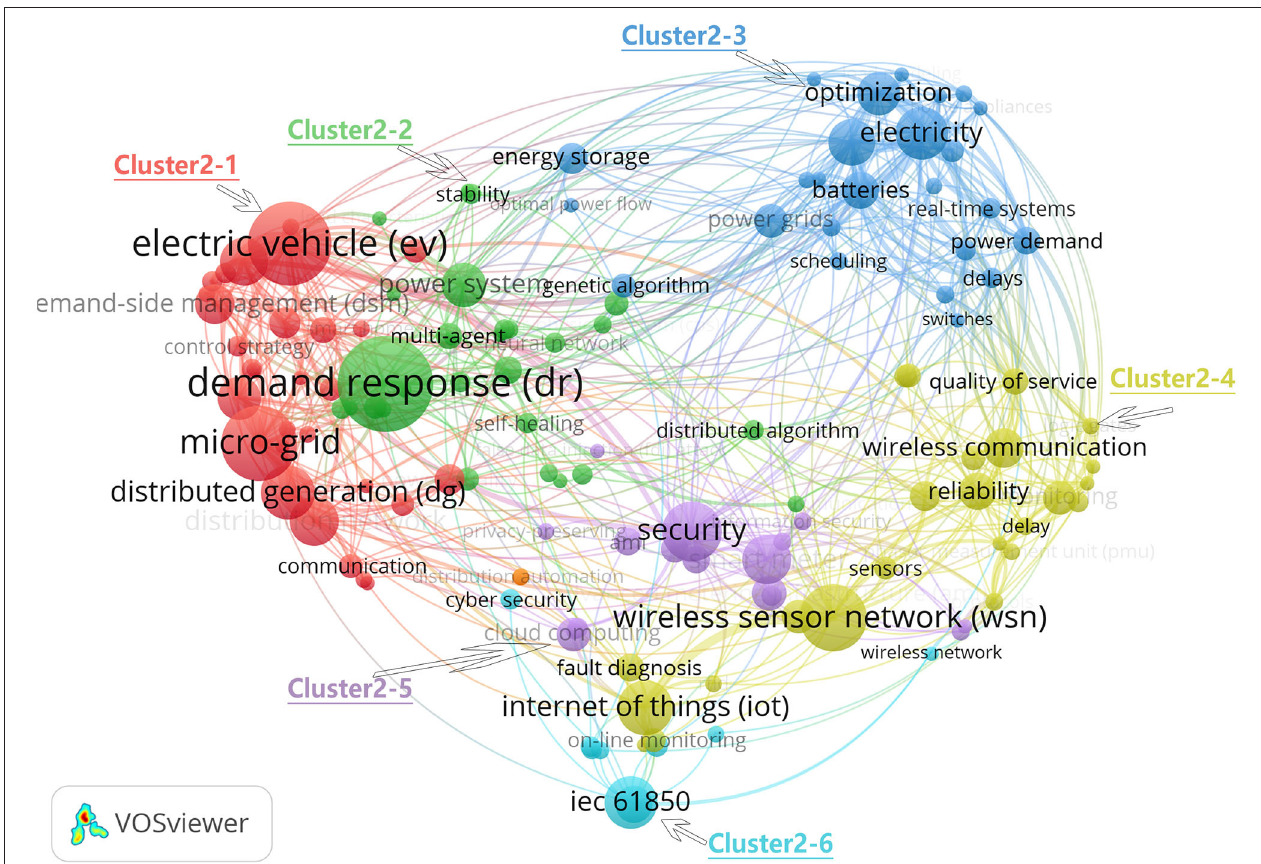
FIGURE 9 | Author-keywords co-occurrence network of SG publications in China, 2010–2014. A total of 3,185 keywords, VOSviewer parameters: minimum occurrence is 5, normalization method: LinLog/modularity, attraction = 1, repulsion = 0, clustering: resolution = 1, min. The cluster size: 5. Search keywords such as smartgrid, smart grid, and smart grids are not